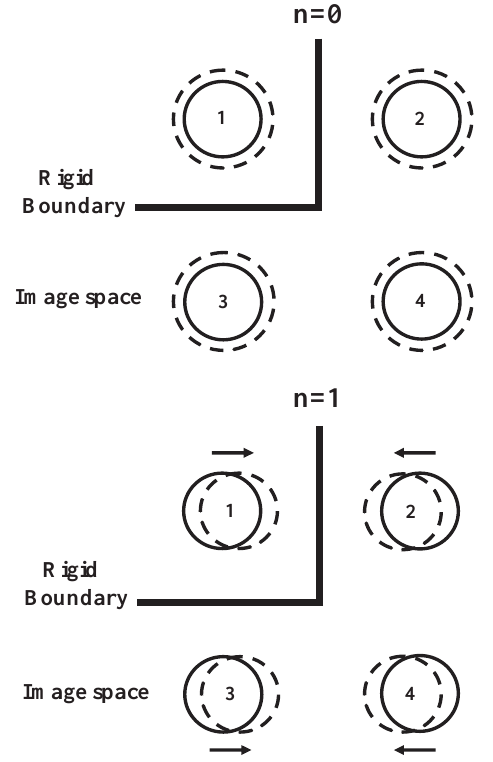
Fig. 3. Image of a pulsating and an oscillating source at a rigid